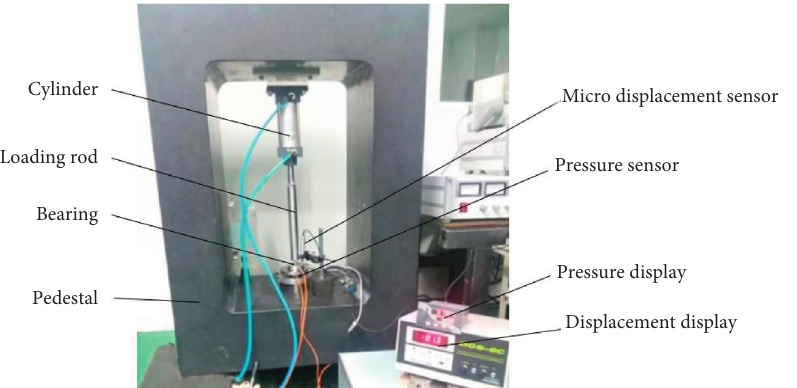
Figure 12: Test bench.